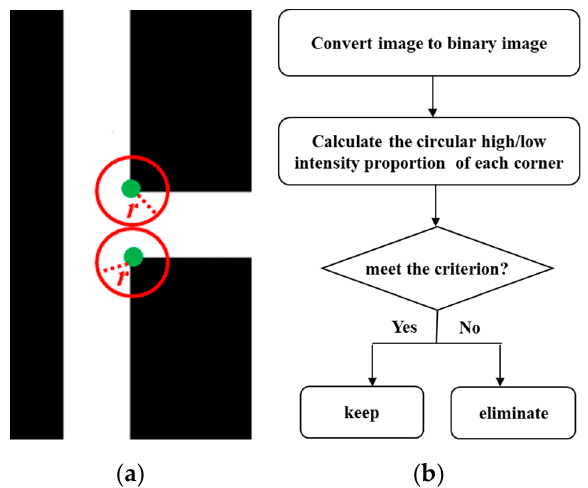
Figure 6. Circular intensity proportion. ( a ) Diagram; ( b ) Flowchart.